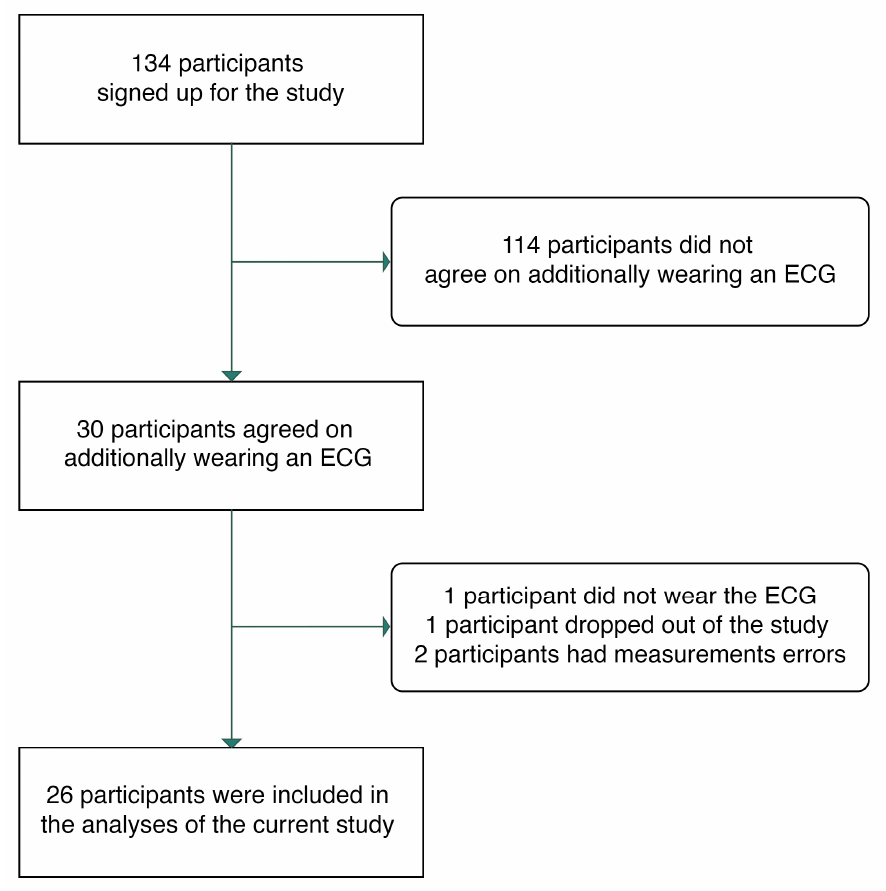
Figure 1. Participant inclusion flowchart.